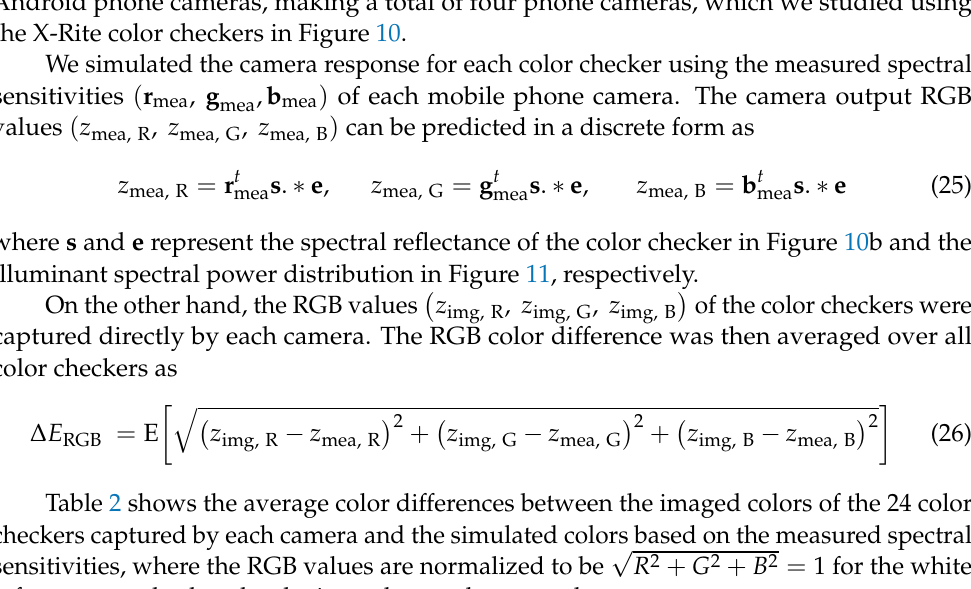
Figure 11. Illuminant spectral power distribution of the incandescent lamp used.